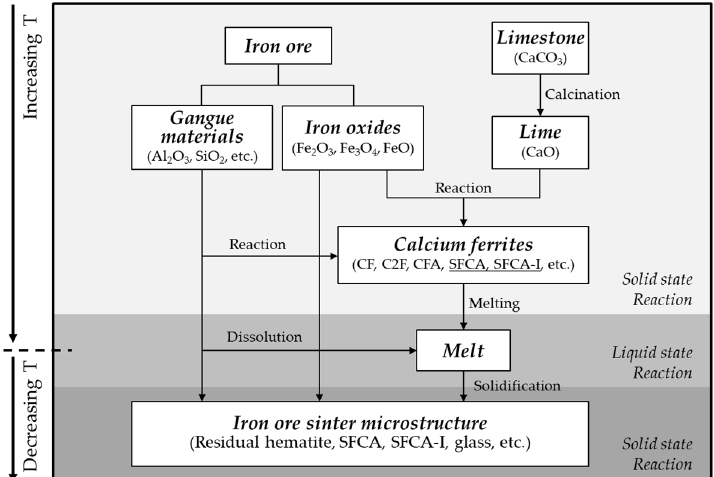
Figure 3. Schematic of the formation mechanism of the microstructure of iron ore sinter. Modified from Jeon et al. [13].